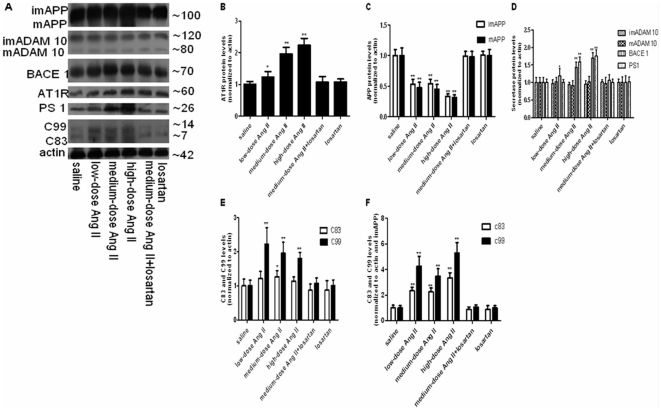
Expression assays for AT1R and APP processing pattern by WB.The same gels were blotted for β-actin as an internal standard. n = 6 for each group. (A) Representative enhanced chemiluminescence radiographs of immunoblots showing the immunoactivities of AT1R, APP, ADAM 10, BACE1, PS1, C83, C99 and β-actin. Density analysis showing levels of (B) AT1R, (C) APP, (D) ADAM 10, BACE1, and PS1, (E) (F) C83 and C99. Data in (B–E) were normalized by dividing the density of the AT1R, ADAM 10, BACE1, PS1, C83 and C99 bands by the density of the β-actin band. Data in (F) were normalized by dividing the density of the C83 and C99 band by that of the β-actin band and then the imAPP band. All data were represented as fold increases over the saline controls. *p<0.05 or **p<0.01 versus the control group receiving saline infusion. imAPP, immature APP; mAPP, mature APP; imADAM 10, immature ADAM 10;mADAM 10, mature ADAM 10.